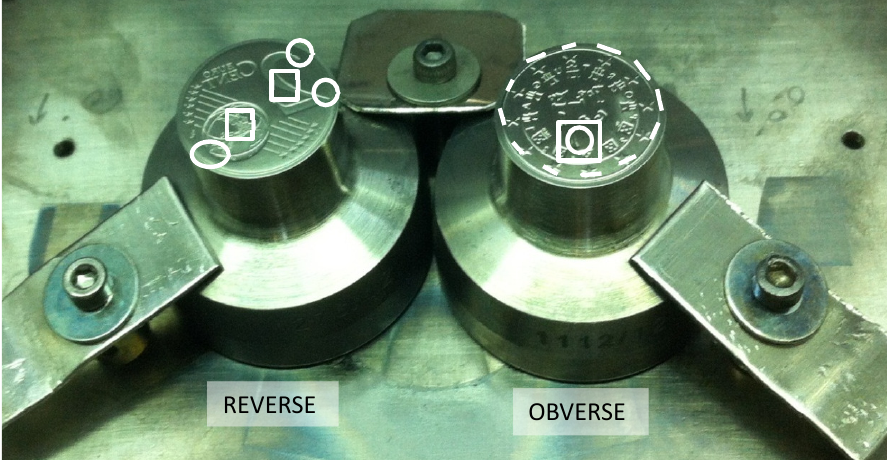
Figure 6. The most common sites of occurrence of fractures in the 2 euro cent coinage dies (marked in white circles) and the cracks that appeared in the implanted dies (marked in white